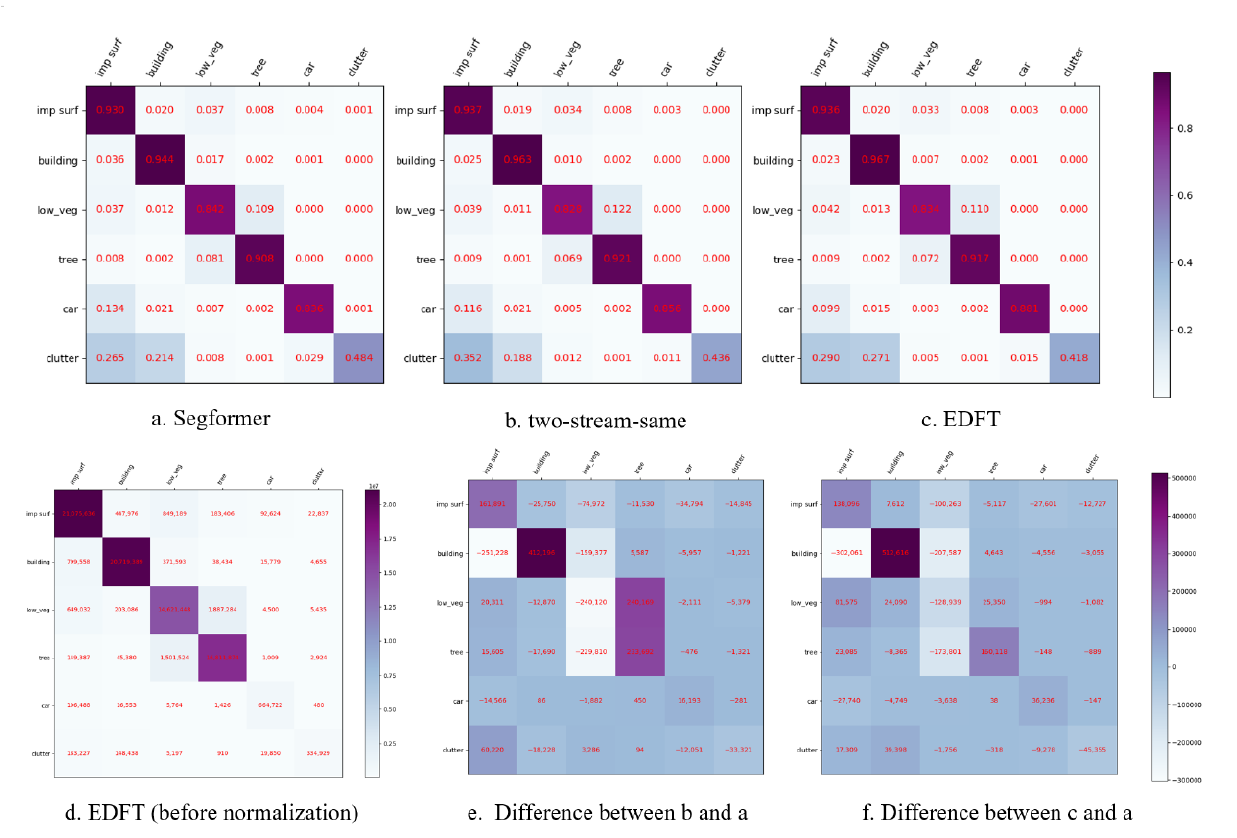
Figure 7. Visualization results of confusion matrices on Vaihingen test set. The top row displays three compared models (Segformer, “two-stream-same”, EDFT), and the model size is B0. The bottom left is the confusion matrix of EDFT without normalization. To make it easier to compare, we visualize the difference between the confusion matrix of Segformer and the one of the other two models (bottom middle and